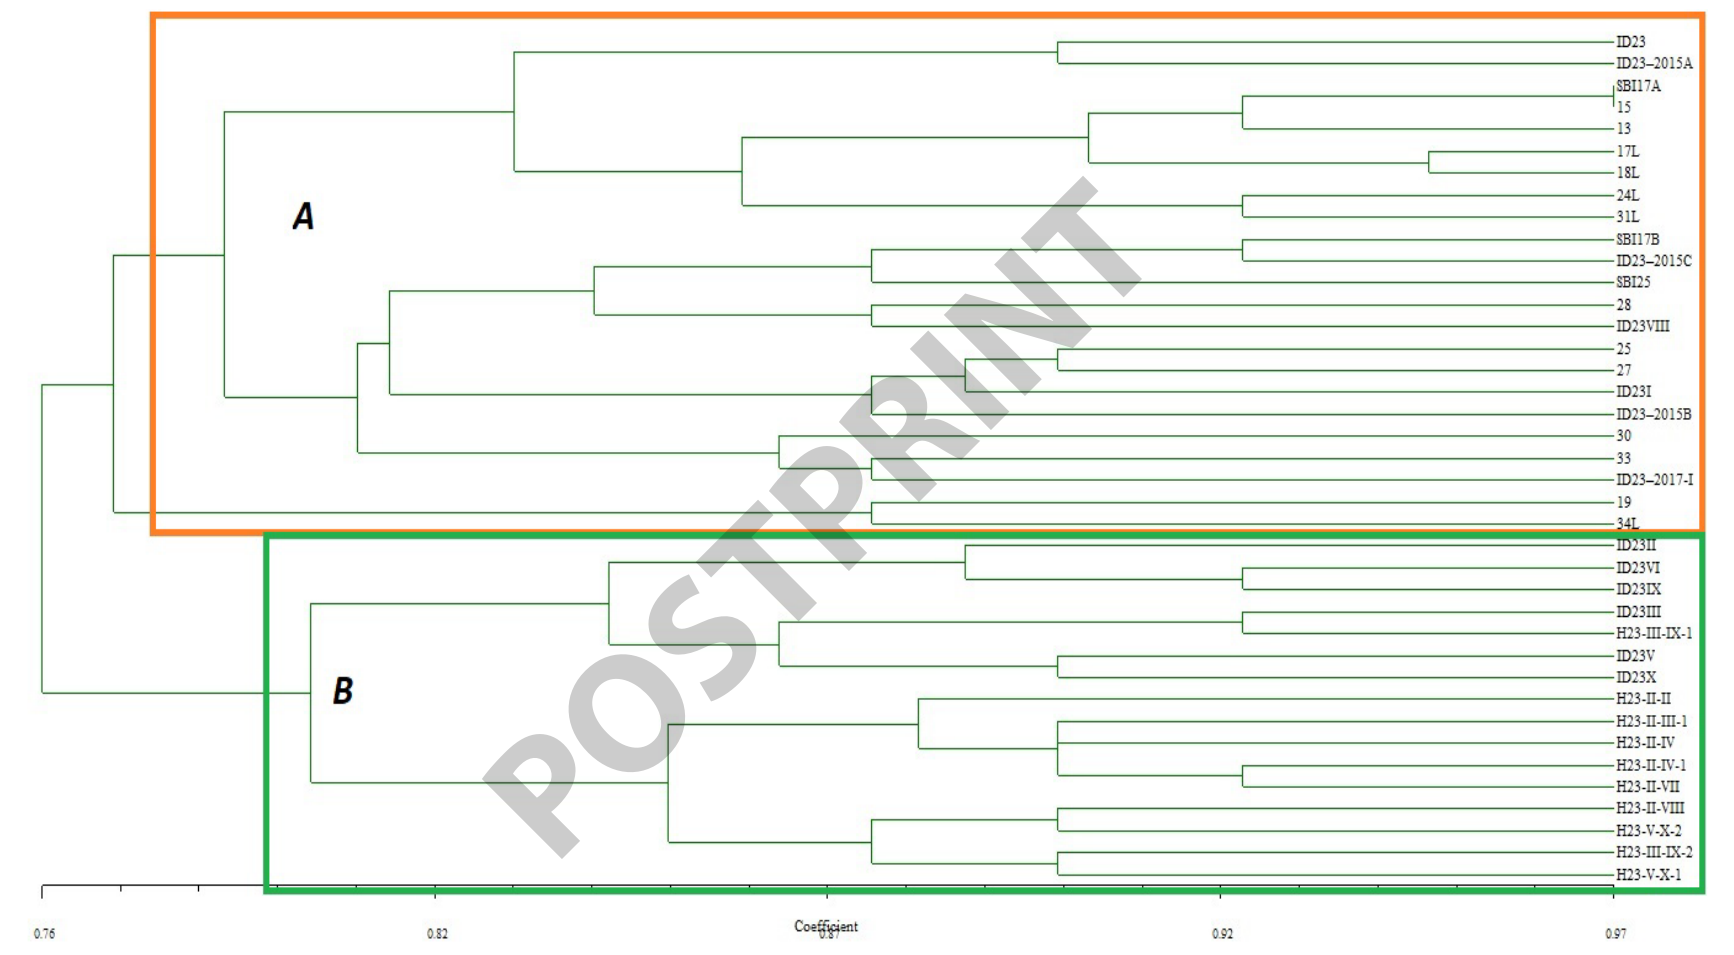
Figure 1. Similarity tree based on morphological features of maternal strain ID23 and its progenies . Strains with letter “H” in a code are